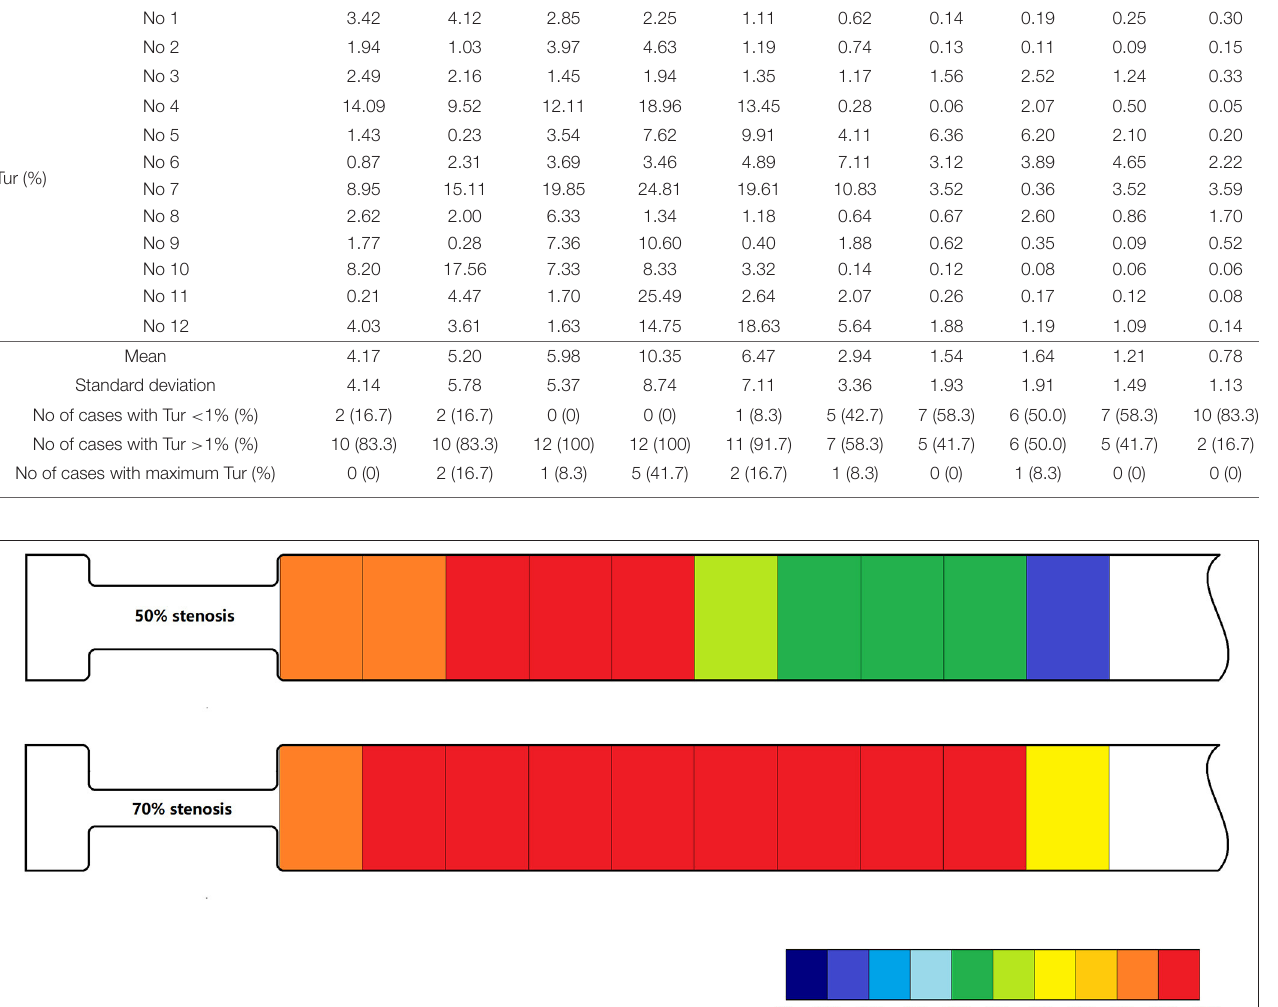
TABLE 2 | Tur indices (%) distal to a 50% stenosis in 12 canine femoral arteries. Distance distal to stenosis (mm)